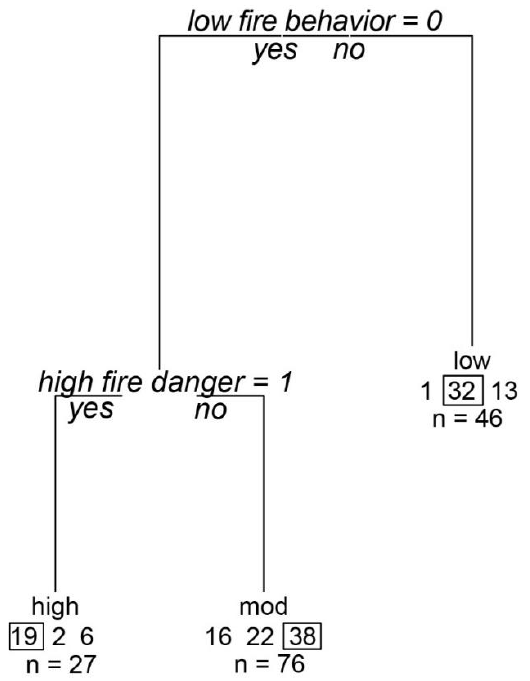
Figure A3. Northwest CART model classifying high, moderate and low relative risk.